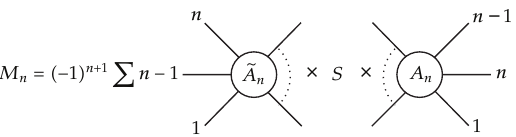
Figure 3: Diagrammatic representation of the KLT relation with j (cid:6) n − 1